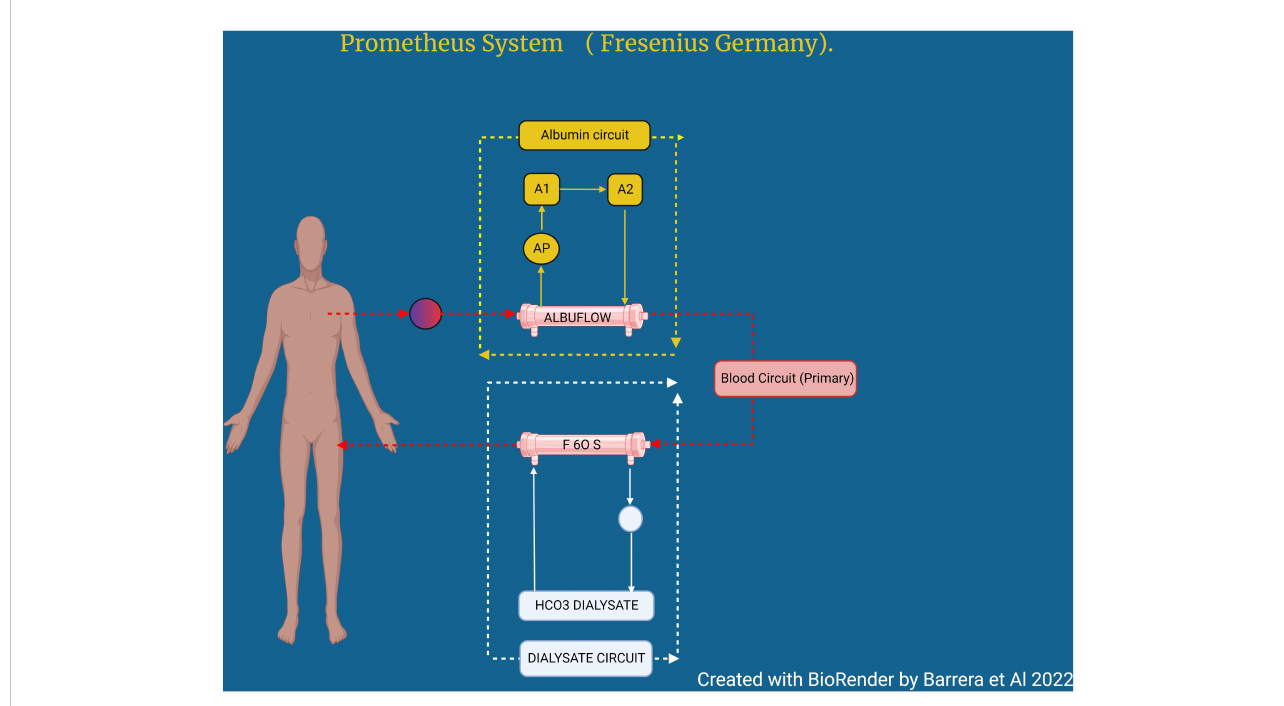
FIGURE 5 Prometheus system (Fresenius